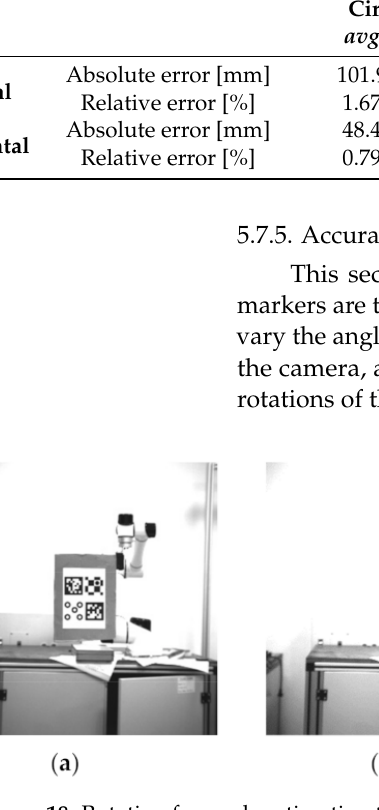
Figure 18. Rotation for angle estimation test: ( a ) The yaw of 0 ◦ ; ( b ) The yaw of 70 ◦ ; ( c ) The roll of 0 ◦ ; ( d ) The roll of 80 ◦